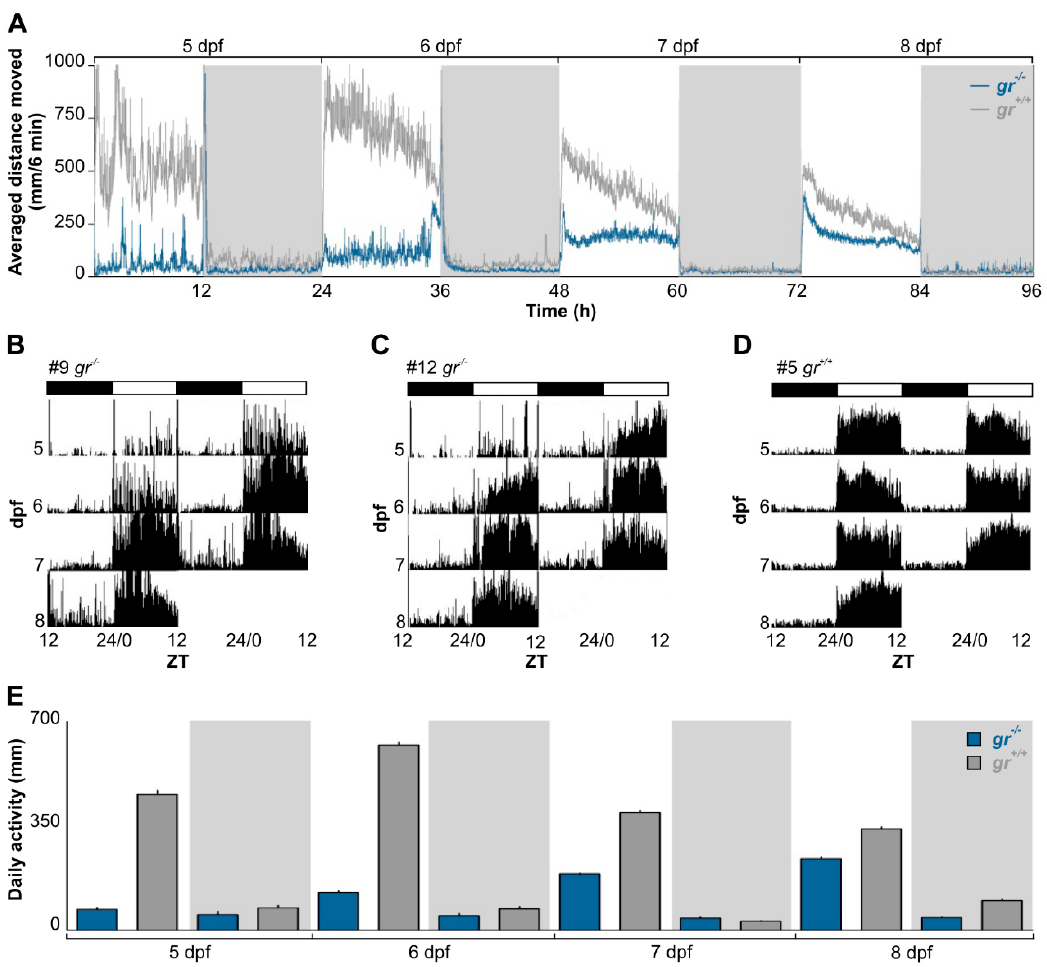
Figure 2. Daily activity rhythms of gr +/+ and gr − / − larvae zebrafish. ( A ) Mean waveform of locomotor activity under 12:12 LD cycles from 5 to 8 dpf (n = 120 / genotype). Vertical axis shows averaged distance moved (mm / 6 min) while x axis indicates time in recording. White and grey bars show light and dark phase, respectively. Data are expressed as mean ± standard error of the mean (SEM). ( B – D ) Representative actograms of 3 zebrafish ( gr − / − : B , C ; gr +/+ : D ). Actograms are double plotted on a 48 h time scale to help the interpretation. The height of each point represents the distance travelled in 6 min. Bars at the top of each actogram indicate light (white) and dark (black) phases the LD cycles. The age of zebrafish is indicated on the left and the zeitgeber time (ZT) is plotted on the bottom of each actogram. ( E ) Mean activity (n = 120 / genotype) in the light and dark phases from 5 to 8 dpf. Data are expressed as mean ± SEM.